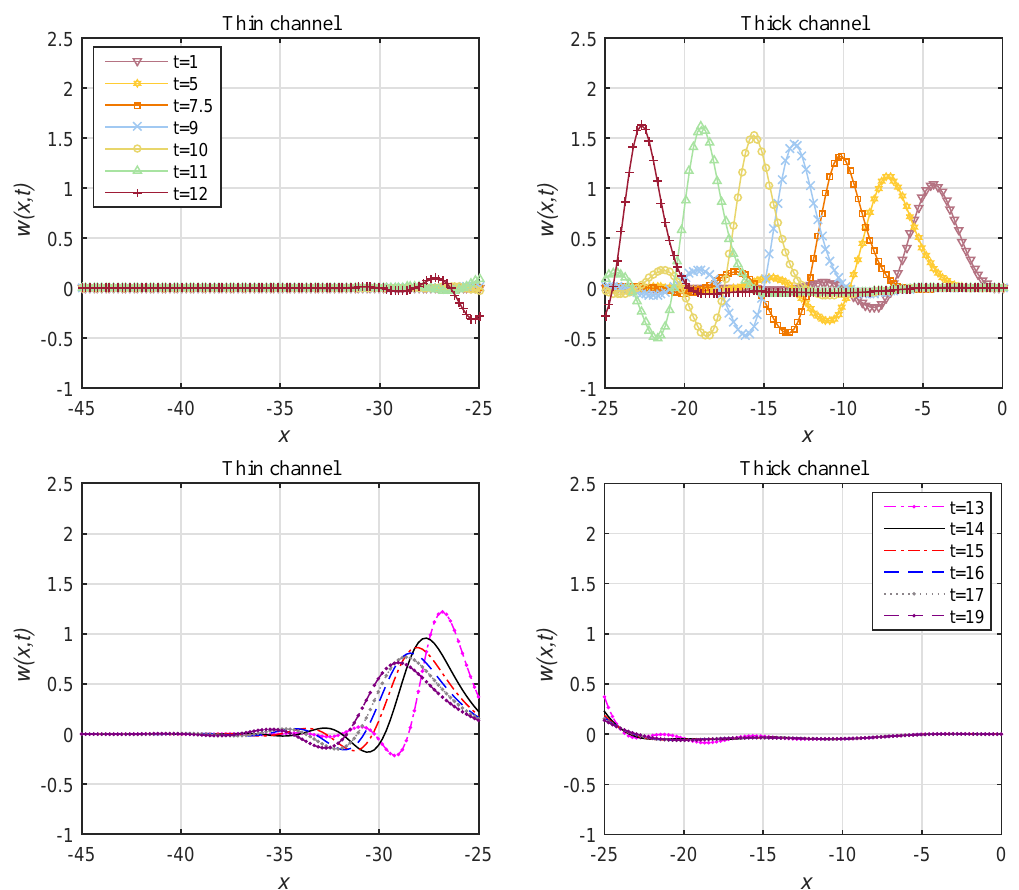
Figure 5. Pulse propagation through the contact point showing the ( top ) early and ( bottom ) late stages (1 < t <